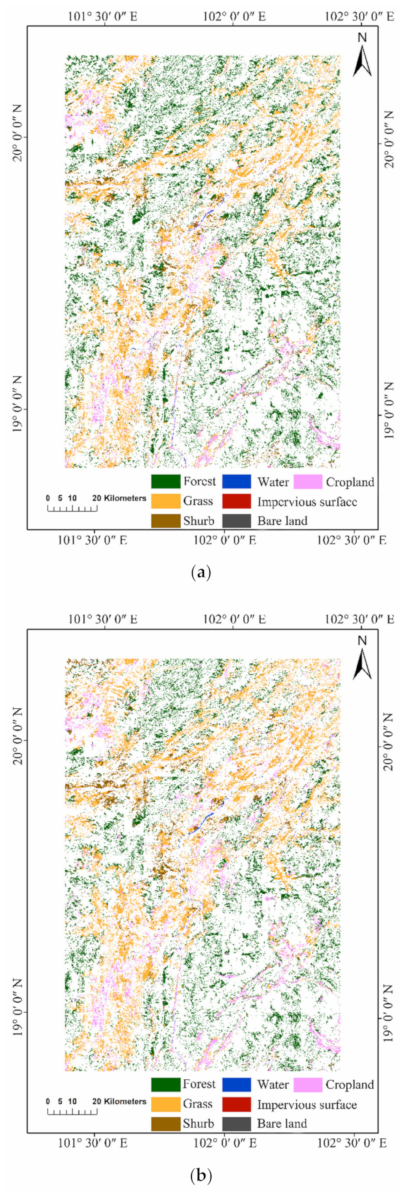
Figure 13. Changed patches classification result images of the study area: ( a ) 2016; ( b )